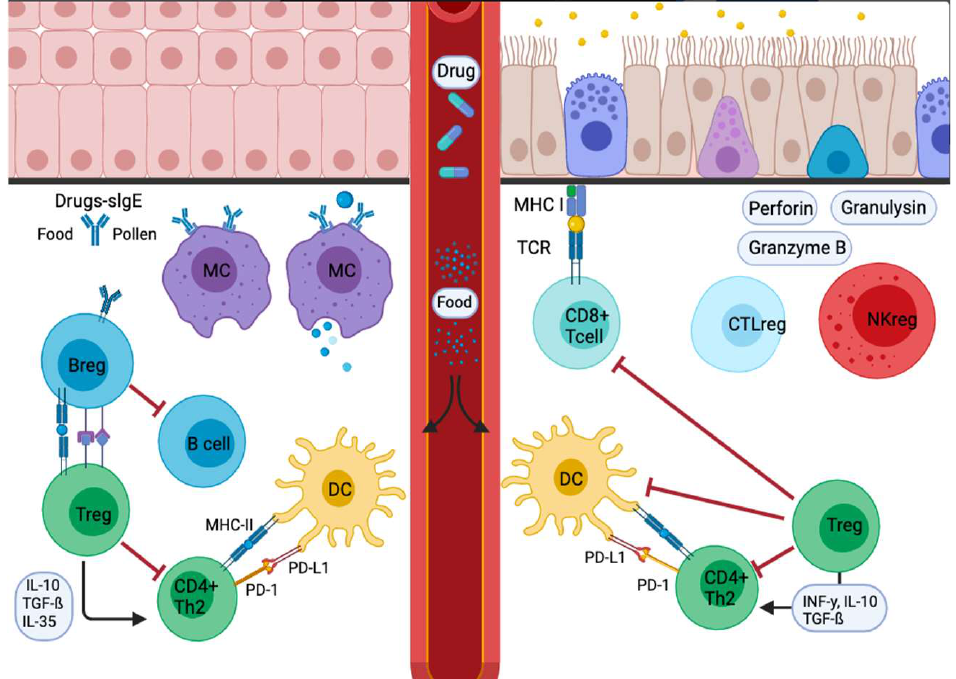
Figure 3. Signal inflammatory cascade allergy response in mucosas. Incoming allergens are taken up and processed by APCs or antibodies. Allergens cross the mucosa, then move to the lung pleura or intestine. In the sensitization stage, APCs present the antigen and give an immediate response. Others migrate to the draining lymph nodes, where the processed allergen is presented to naïve T and B cells, responses characterized and influenced by the cytokines secreted and the presence or absence of cell-bound co-stimulatory molecules. Decreased stimulus and/or the presence of IL-10, IL-35, or TGF- β triggers Treg cell transformation. In addition, APCs lead to the production of cytokines that regulate the change and expression of coinhibitory receptors such as PD1/PD-L1.